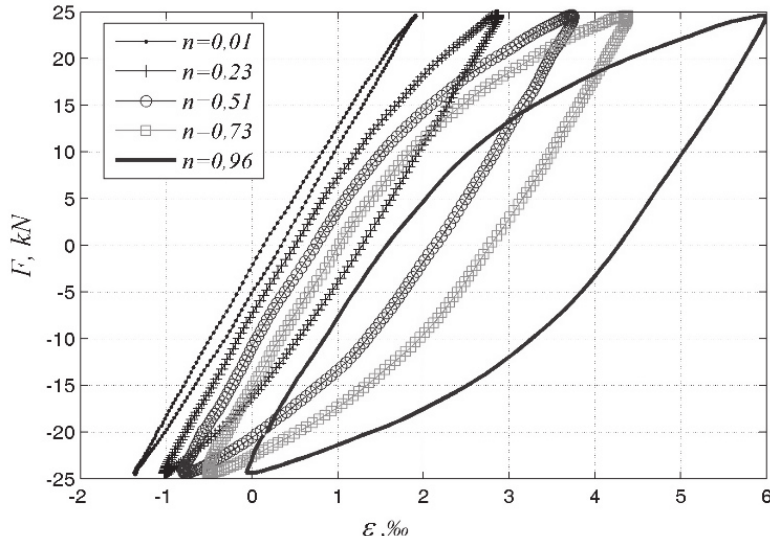
Figure 7: Hysteresis loops recorded during fatigue